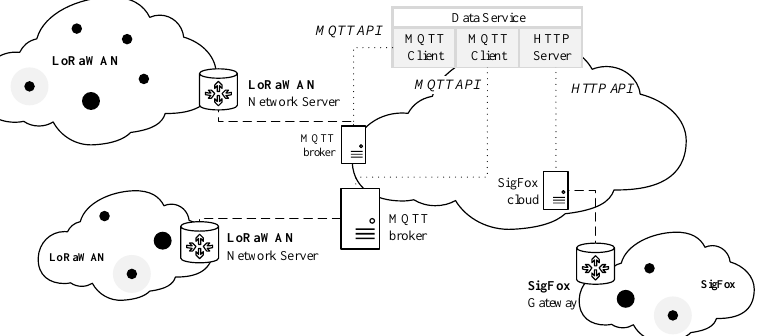
Figure 1. The current Low-Power Wide-Area Network landscape: centralized components deliver data to translation